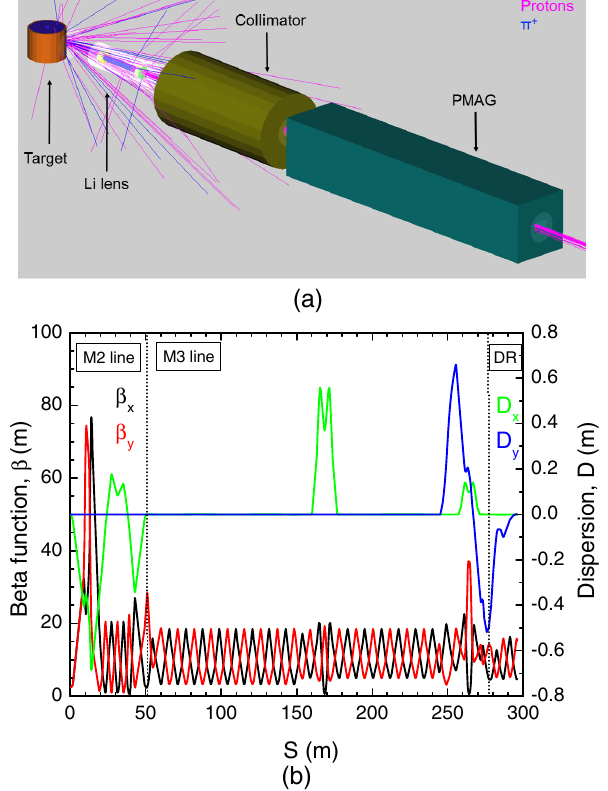
FIG. 2. (a) A Schematic representation of the Muon Campus target station, where the positive pion ( π þ ) and proton trajectories are shown in blue and pink respectively. (b) The optics functions are shown for the M2- and M3-line, where the lattice is designed to have a transverse acceptance of 40 mmmrad, and a narrow momentum acceptance of Δ p=p ¼ (cid:2) 2 %. The beam line has 120° phase-advance cells between S ¼ 23 . 2 m and 35.6 m, 90° phase- advance cells between 65.4 and 143.1 m, and 72° phase-advance cells between 177.8 to 240.2 m. The point of intersection between M2 and M3 is at S ¼ 50 . 0 m, the two 9.25° horizontal bending magnets are at S ¼ 160 . 0 m and S ¼ 174 . 0 m, while injection to the DR occurs at S ¼ 280 . 0